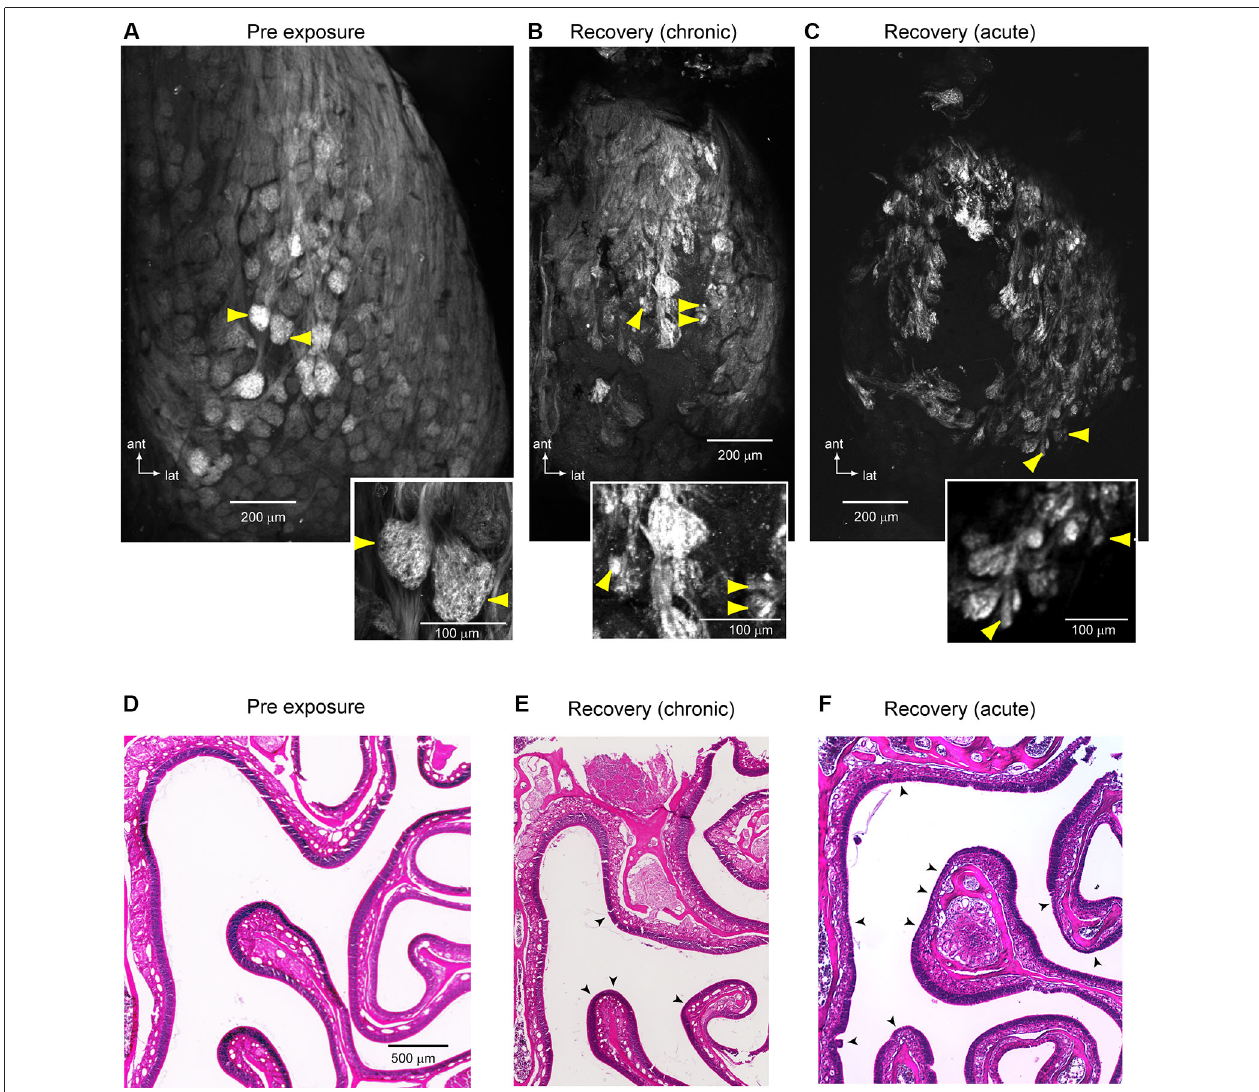
detail in insets ). In addition, regions of the central dorsal OB appear to lack innervation by OSNs. (D–F) H&E-stained sections of the OE from the same animals shown in (A–C) . In (E) , there is substantial but not complete recovery of the epithelium. Arrowheads indicate areas with a reduced contingent of neurons as compared to the protected side. In (F) , much of the epithelium remains less than fully recovered. Arrowheads indicate areas that are grossly abnormal and completely lacking in